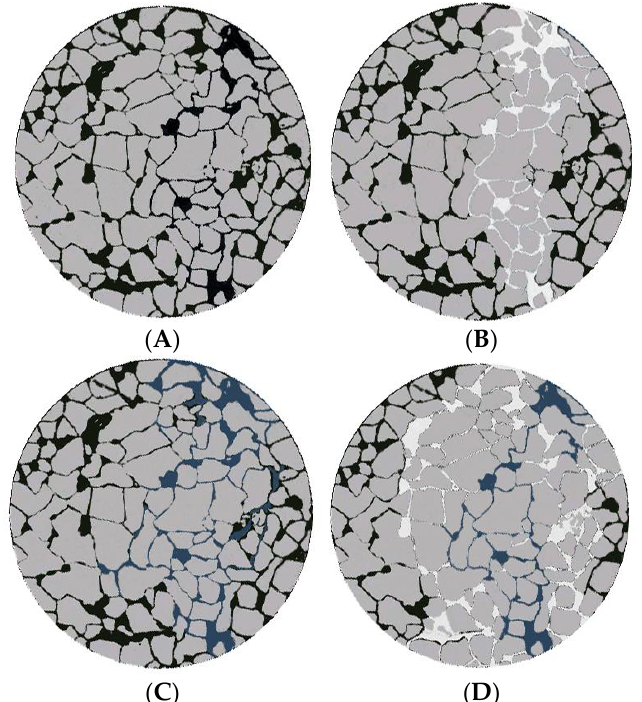
Figure 16. Schematic representation of the oil displacement effect produced by the microsimulation glass etching model. ( A ) Initial; ( B ) Water flooding; ( C ) Gel injection;( D ) Subsequent water flooding.